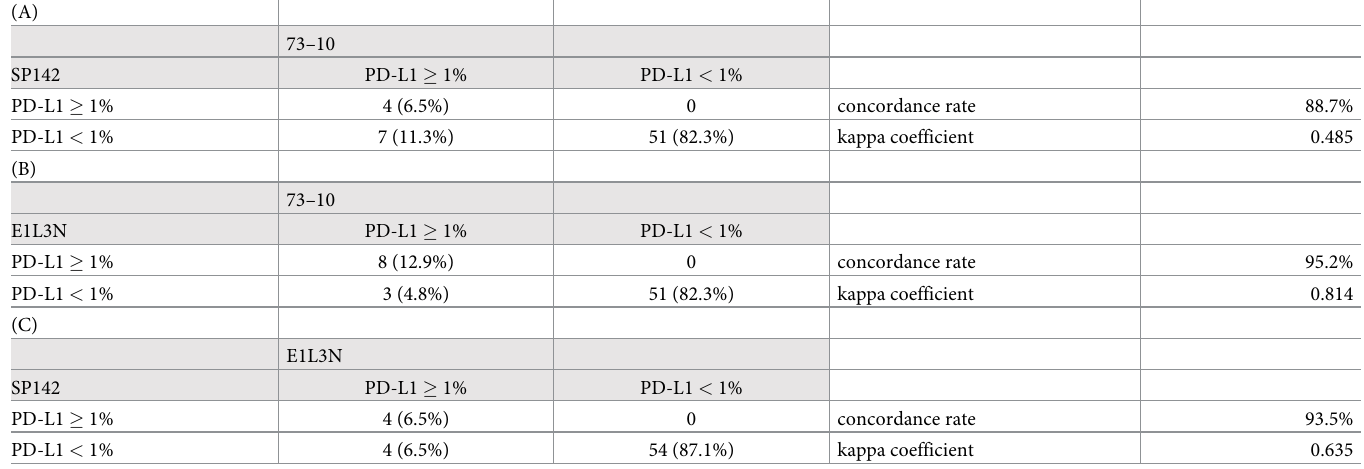
Table 3. Comparison of PD-L1 expression on TCs by 73–10, SP142, and E1L3N assays.